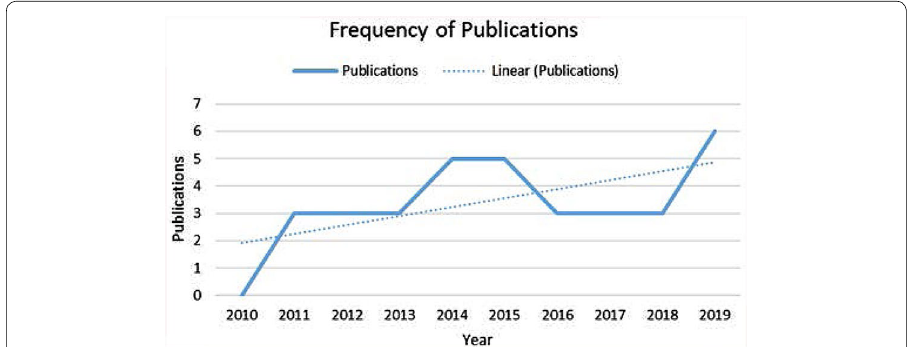
Fig. 2 Frequency of publications on transversal competences